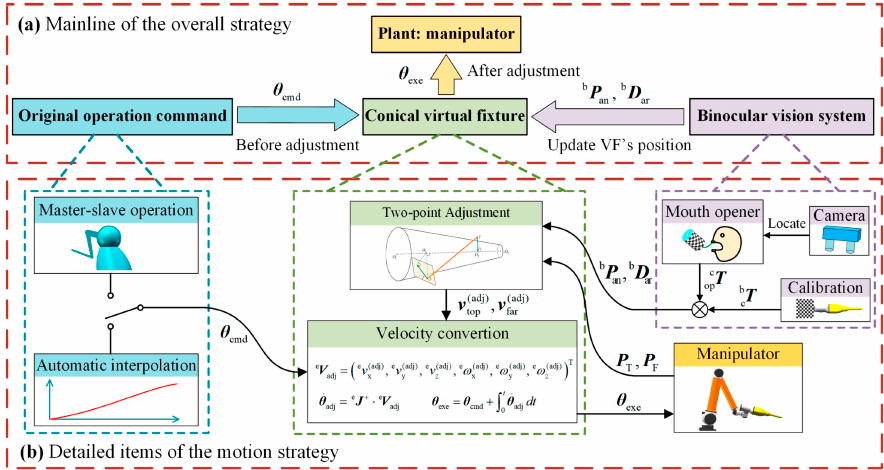
Figure 14. The overall motion strategy: ( a ) The mainline; ( b ) The detailed items.